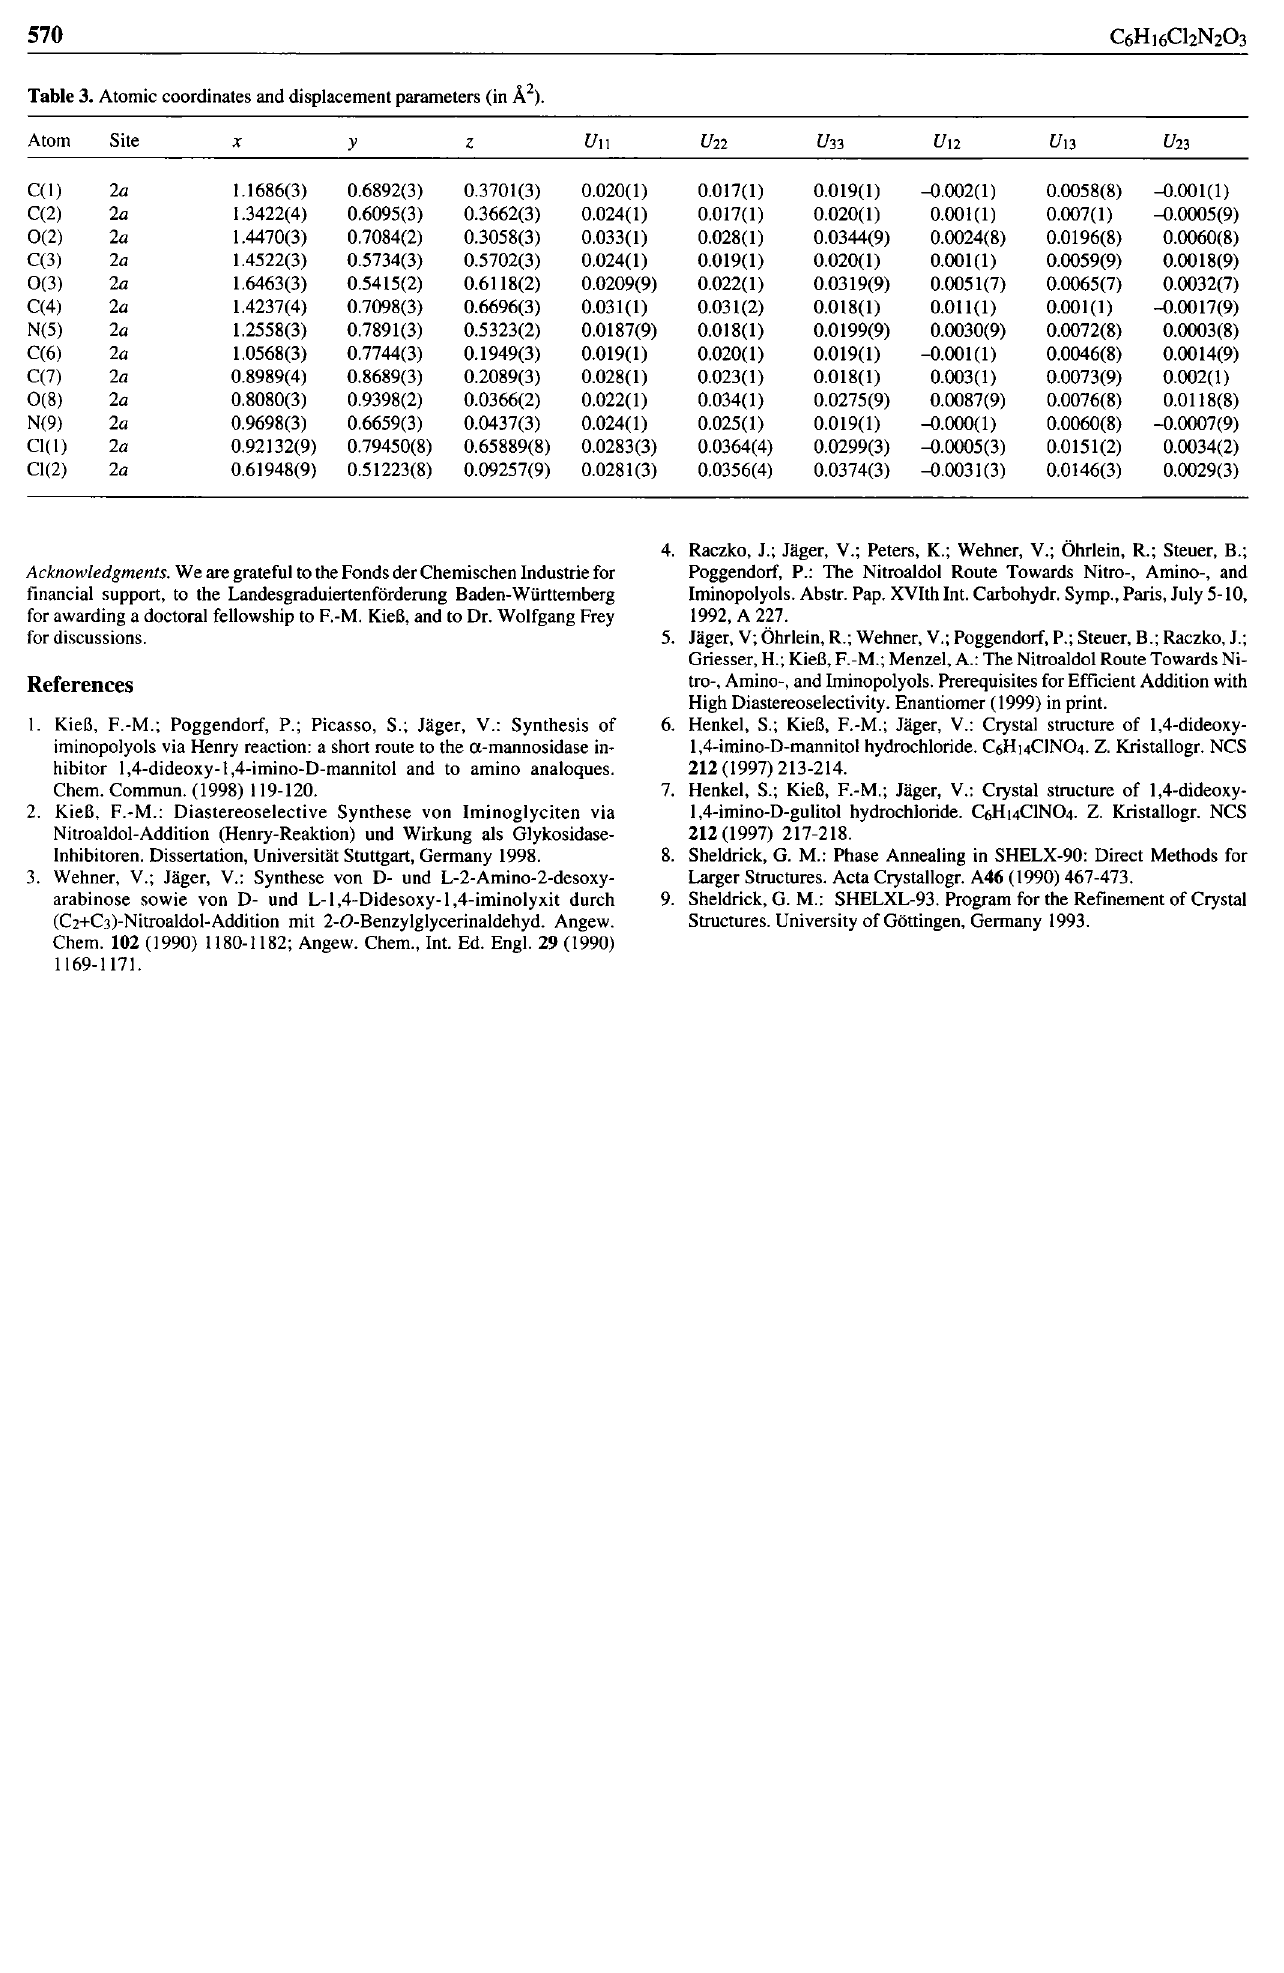
Table 3. Atomic coordinates and displacement parameters (in Ä 2